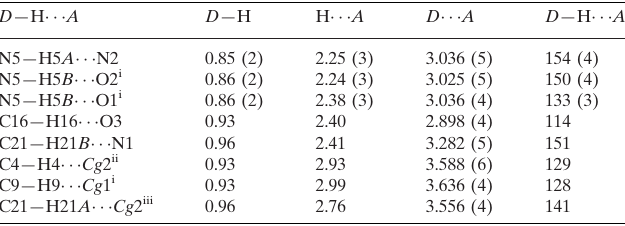
Hydrogen-bond geometry (A˚ , (cid:3)